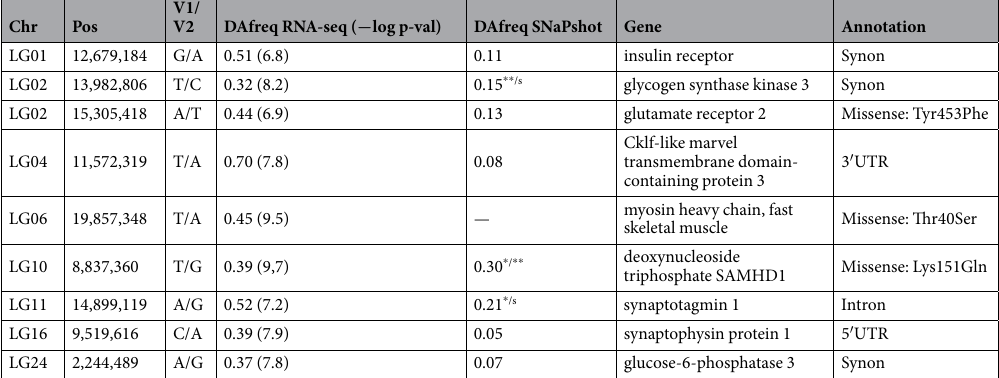
this species, essential for understanding the mechanisms underlying phenotypic variation of this complex trait and useful for genetic assistance in breeding programs. The transcriptome profiles at 270 dpf here obtained also contribute key information to be further compared with other life-cycle stages with different weight of hyperpla- sia and hypertrophy into myogenesis 5 . Some candidate genes were individually validated using qPCR in FG and SG fish in turbot families. Aggregated individual qPCR results were mostly in agreement with RNA-Seq pools; however, some genes showed inter-family transcriptomic differences, suggesting that functional strategies asso- ciated with growth rate in turbot may be diverse among families, as previously reported for other complex traits in teleosts 31 . Our results are consistent with previous growth-association studies in turbot and other fish, where some genomic regions showed association across families, while others were family specific 17,18,32 . Furthermore, SNaPshot assays validated the association of some growth-related SNP variants identified through differential allele frequencies between FG and SG pools in the transcriptomic analysis. These gene markers could be useful for studies in other families and/or populations, or even for genome editing approaches for those potentially functional variants. Up-regulation of all glycolytic enzymes along with lactate dehydrogenase was consistently observed in our study, which supports a higher oxidation rate of glucose by fermentation in muscle to increase growth rate. Unlike other vertebrates, fish muscle is separated in discrete layers of different fibre types. Vertebrates have two main types of striated muscle fibres, red and white, which in fish specialize in low speed swimming and bursts of maximum speed, respectively 33 . Red muscle fibres (less than 10% of the myotomal musculature) mainly depend mainly on aerobic, mitochondria driven, energy metabolism 34 . On the contrary, the metabolism of white muscle genase (LDH) and CKs in fast-growing turbot strongly suggests a higher white muscle metabolic activity, which would presumably explain their higher growth. Glycolysis has also been found up-regulated in the muscle of